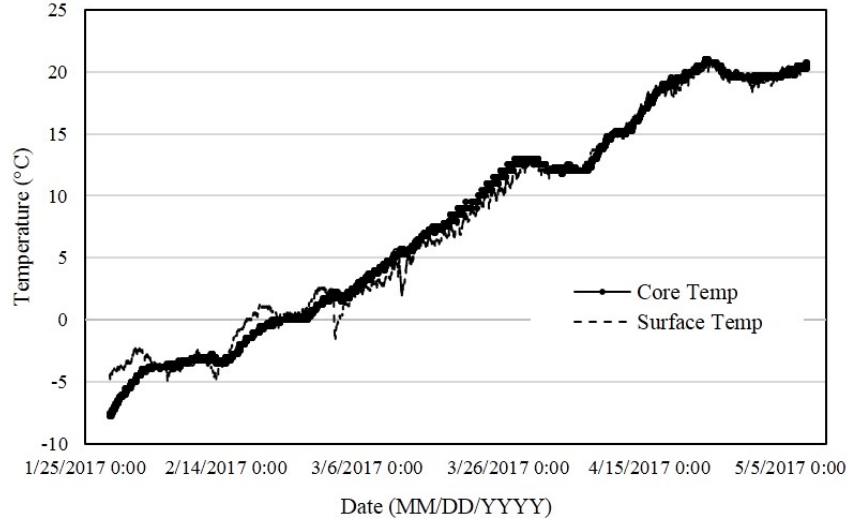
Figure 13. Average sand ‐ bed core temperature and surface temperature.